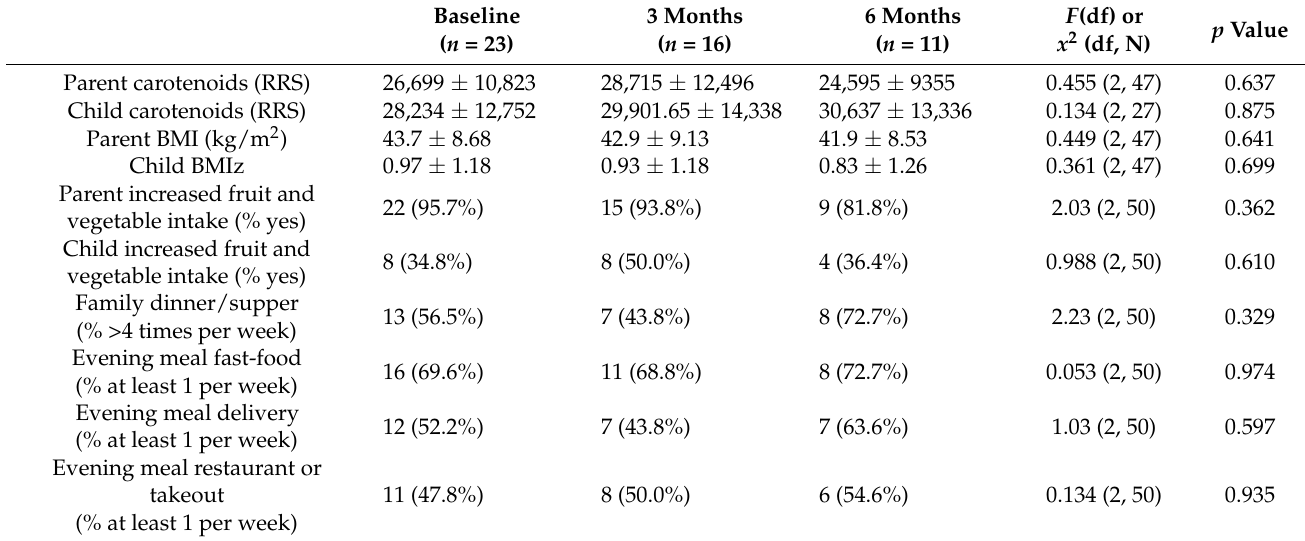
Table 2. Parent and Child Average Scores at Baseline, 3 months, and 6 months.